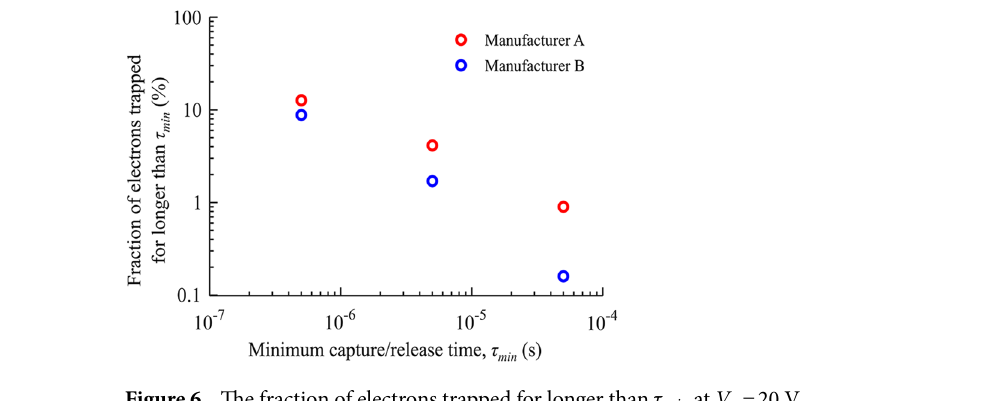
Figure 6. The fraction of electrons trapped for longer than τ min at V G = 20